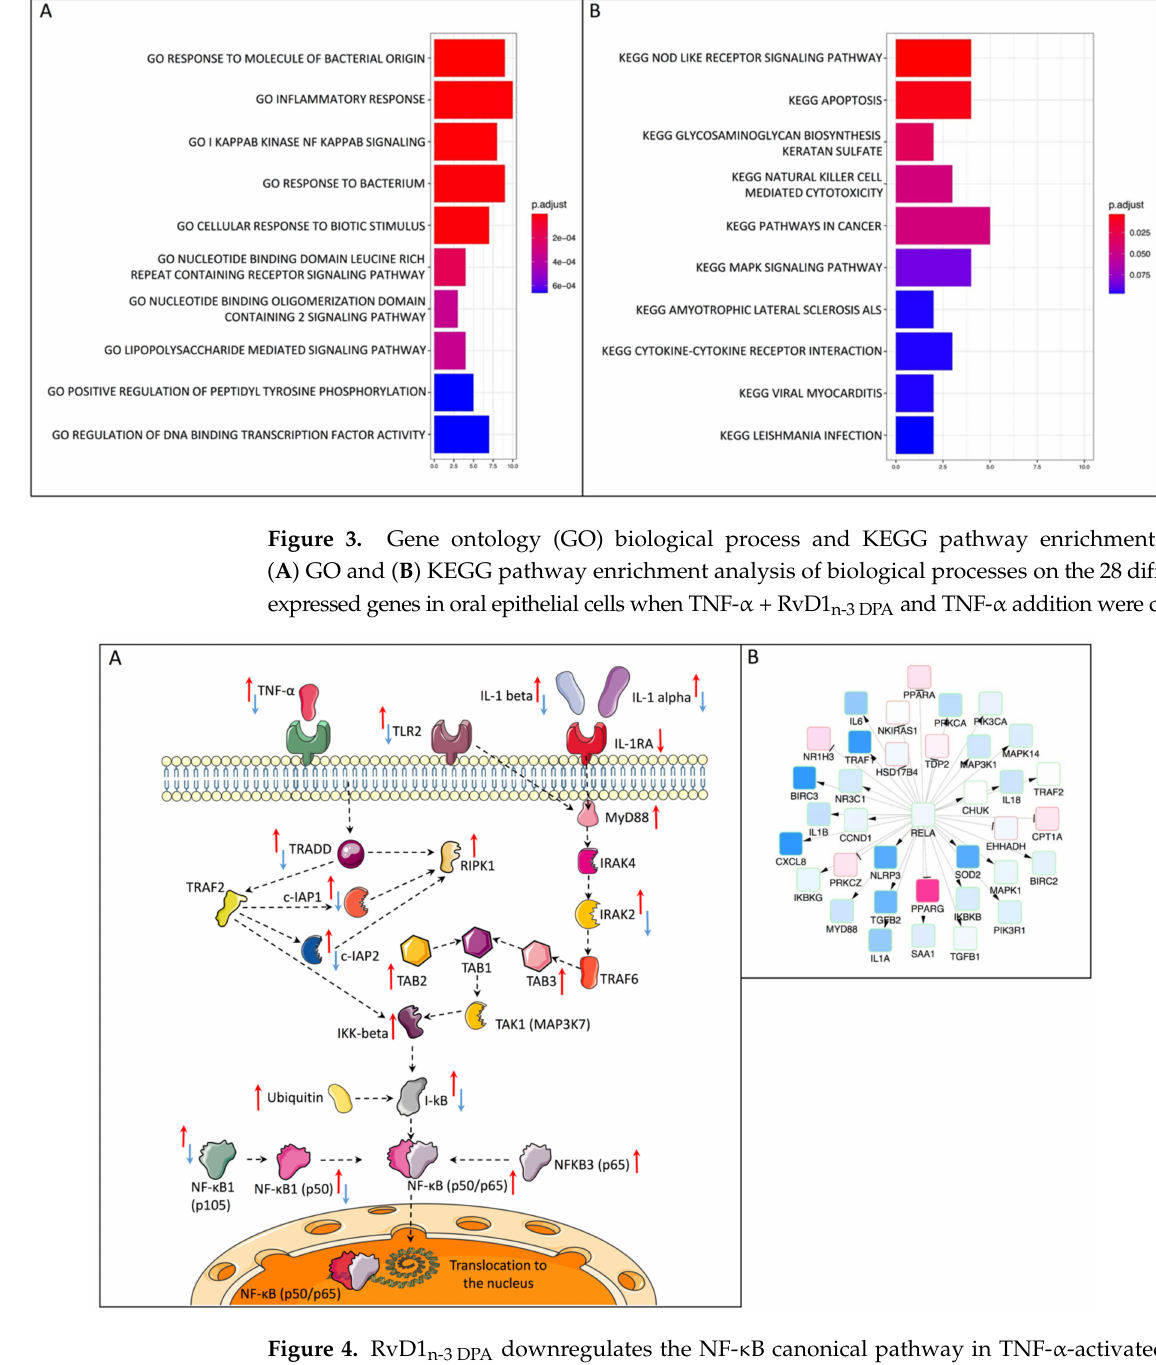
Figure 4. RvD1 n-3 DPA downregulates the NF- κ B canonical pathway in TNF- α -activated oral ep- ithelial cells. ( A ) The canonical pathway of NF- κ B activation. Red arrows indicate transcriptional changes after TNF- α addition. Blue arrows show changes after addition of TNF- α + RvD1 n-3 DPA . ( B ) Causal network analysis centered on RELA , showing that RELA regulates a variety of downstream pro-inflammatory targets for which RvD1 n-3 DPA appears to partly or fully reverse TNF- α -induced expression changes (based on TNF- α + RvD1 n-3 DPA and TNF- α